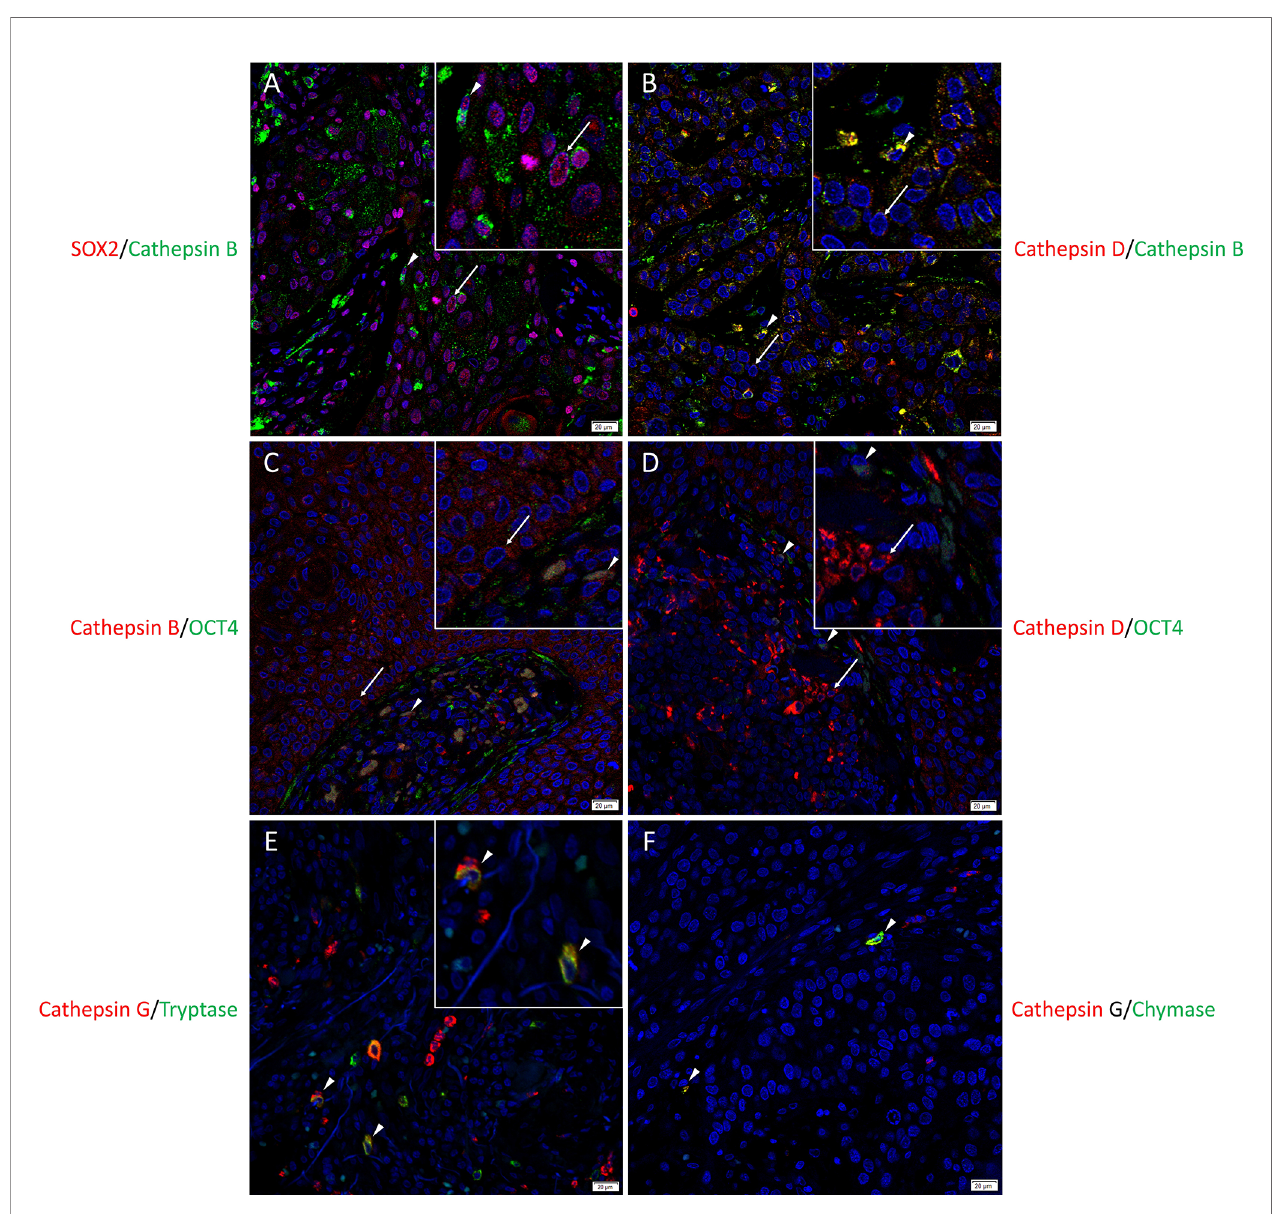
FIGURE 2 | Representative immuno fl uorescence-stained sections of a metastatic cutaneous head and neck squamous cell carcinoma tissue sample demonstrating the co-expression of cathepsins B and D with embryonic stem cell markers. Cathepsin B ( A , green) was expressed by the SOX2+ ( A , red) CSCs within the tumor nests (TNs) and to a lesser extent those within the peritumoral stroma (PTS). Cells that expressed cathepsin B ( B , green) also expressed cathepsin D ( B , red ) . Cathepsin B ( C , red) and cathepsin D ( D , red) were expressed by OCT4+ ( D, E , green) CSCs within the PTS. Cathepsin G ( E, F , red) were expressed by cells within the PTS, majority of which expressed tryptase ( E , green) and few expressed chymase ( F , green). All slides were counter-stained with 4 ′ ,6-diamidino-2-phenylindole ( A – F , blue). Original magni fi cation 400x. Scale bars: 20µm. n = 2. The inserts show enlarged views of the corresponding